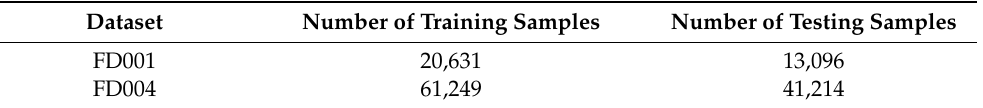
Table 6. C-MAPSS train and test